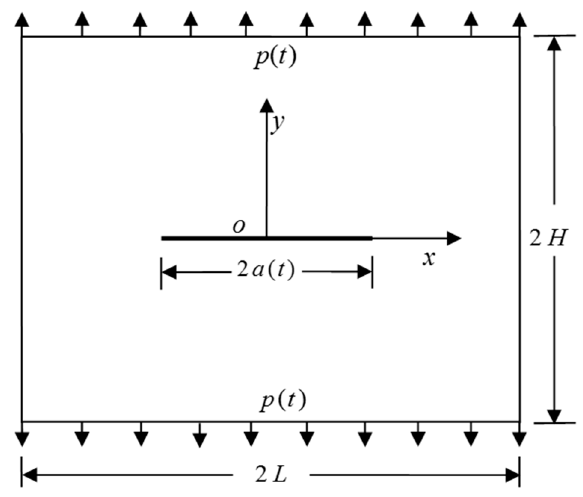
Figure 9. The specimen for icosahedral quasicrystals (QCs) with a Griffith crack.